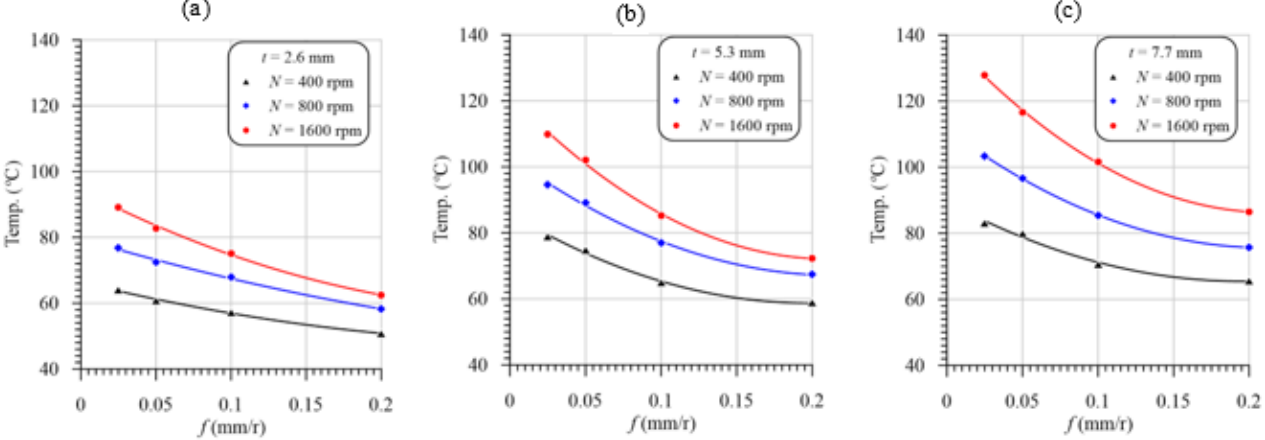
Figure 8. Temperature vs. feed at different speeds and laminate thicknesses of ( a ) 2.6 mm, ( b ) 5.3 mm, and ( c ) 7.7 mm.